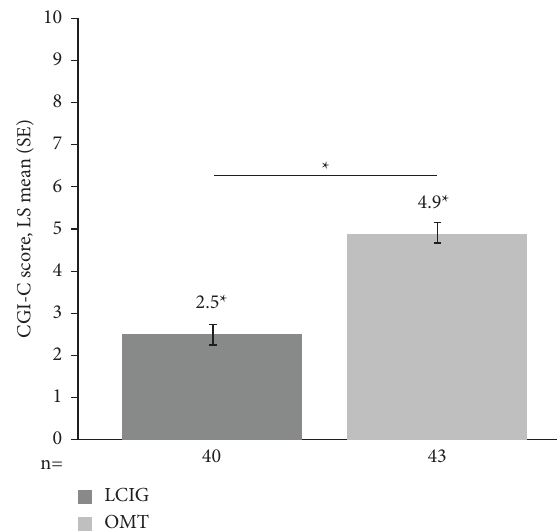
Figure 3: Change at Week 26 in CGI-C in the intent-to-treat population. ∗ Signifcance for between-group diferences (nominal) and within-group diferences at Week 26, p < 0 . 001. CGI-C: Clinical Global Impression of Change, LCIG: levodopa-carbidopa intestinal gel, LS: least squares, OMT: optimized medical treatment, and SE: standard error.